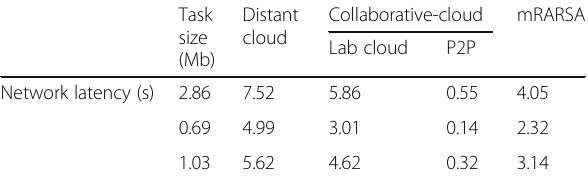
Task Distant Collaborative-cloud mRARSA size cloud Lab cloud P2P (Mb)